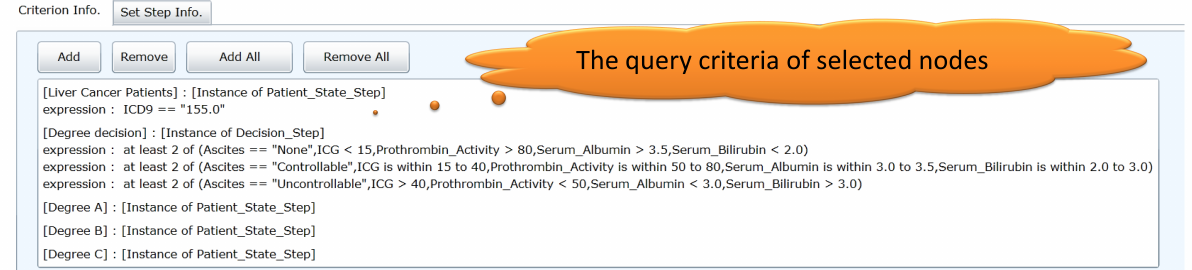
Figure 6. The query criteria of the selected nodes can be displayed in the query criteria selection